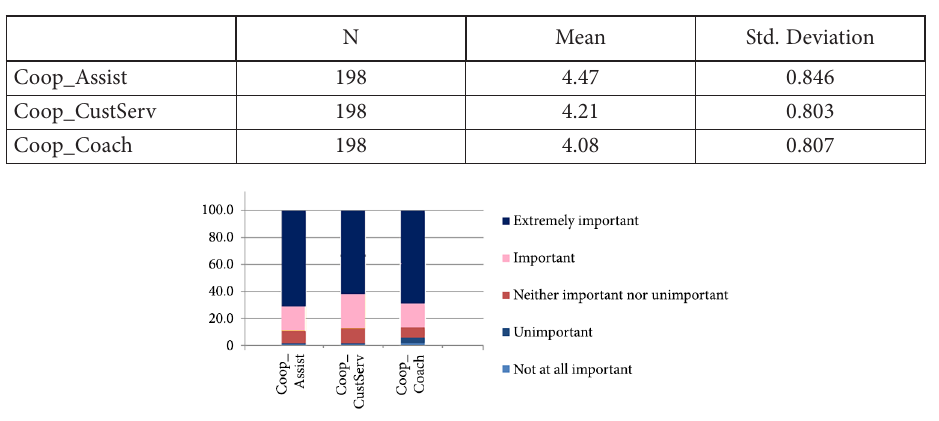
Table 3. Descriptive statistics for the variable firm cooperation